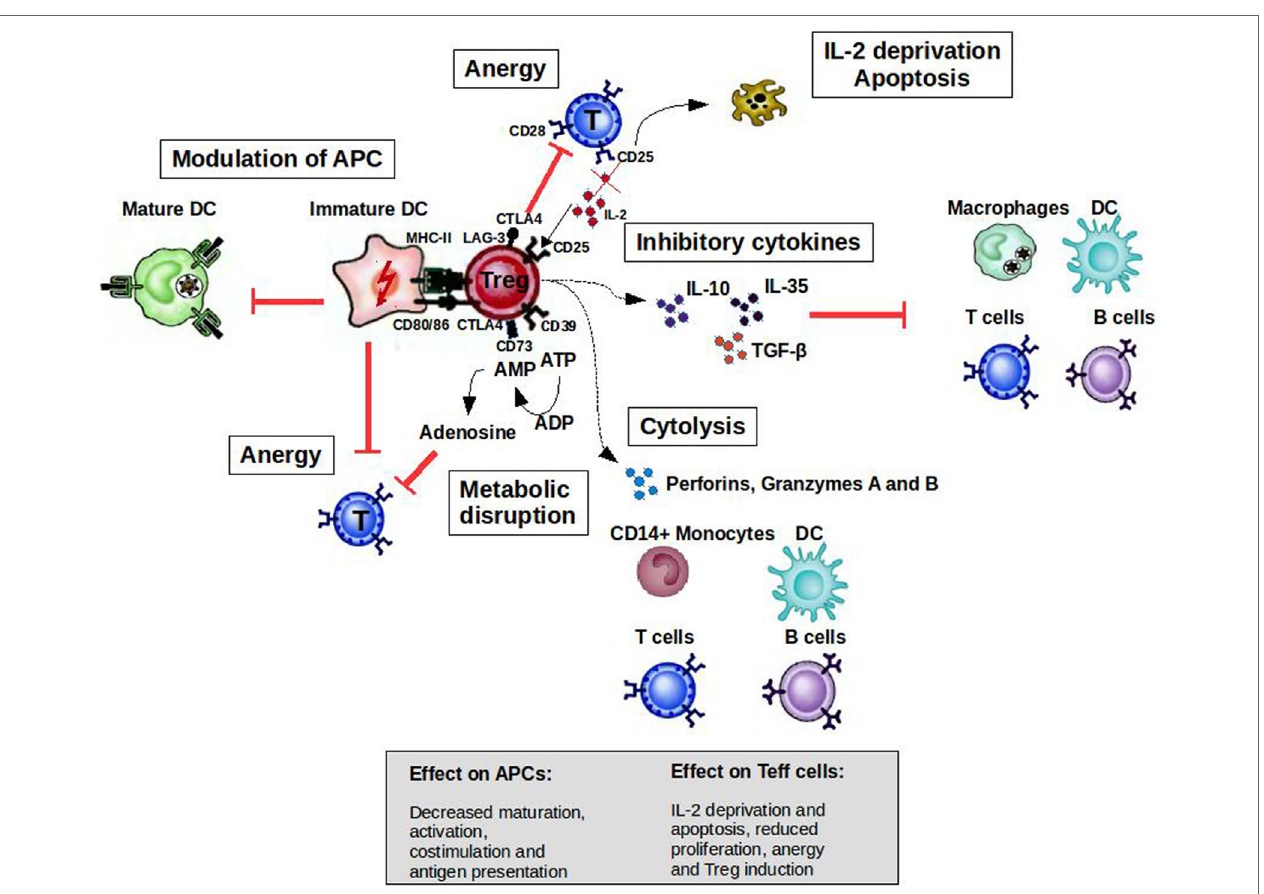
FiguRe 1 | Mechanisms of suppression by Treg cells to control immune responses. A broad range of molecular mechanisms contribute to the suppressive function of Tregs. Mechanisms include the following: apoptosis/cytolysis (IL-2 deprivation, granzyme A/B, perforins); antigen-presenting cell (APC) modulation (CTLA4, LAG-3); inhibitory cytokines (IL-10, IL-35, and TGF- β ); and metabolic disruption (CD73/39 and ATP/adenosine mechanism). Abbreviations: CTLA4, cytotoxic T lymphocyte-associated antigen 4; DC, dendritic cell; CD, cluster of differentiation; IL, interleukin; Treg cell, regulatory T cell; LAG-3, lymphocyte activation gene 3; TGF, transforming growth factor; MHC, major histocompatibility